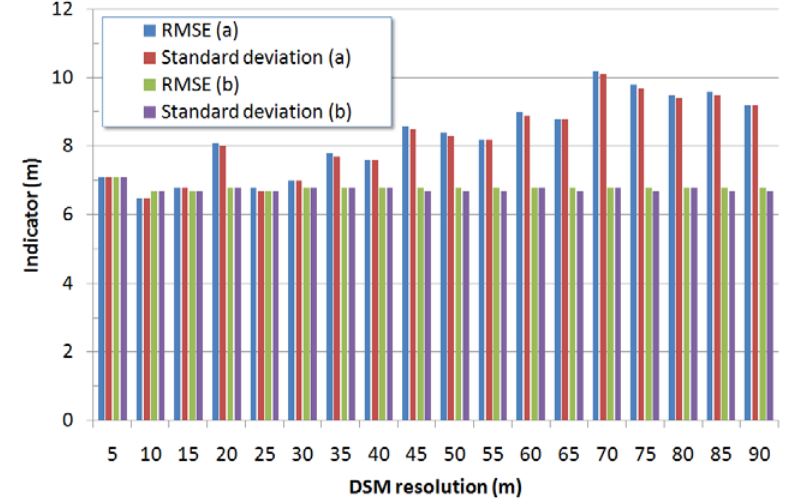
Figure 3. Summary of results for the Cartosat-1 multi-resolution DSMs generated over Mausanne les Alpilles test site. Comparison with respect to the high-resolution reference DSM (reference DSM-Cartosat-1 DSM): (a) for DSMs generated at the desired resolution directly from the Cartosat-1 images; (b) for DSMs generated by downsampling the 5m resolution Cartosat-1 DSM. All values refer to a comparison over the whole test